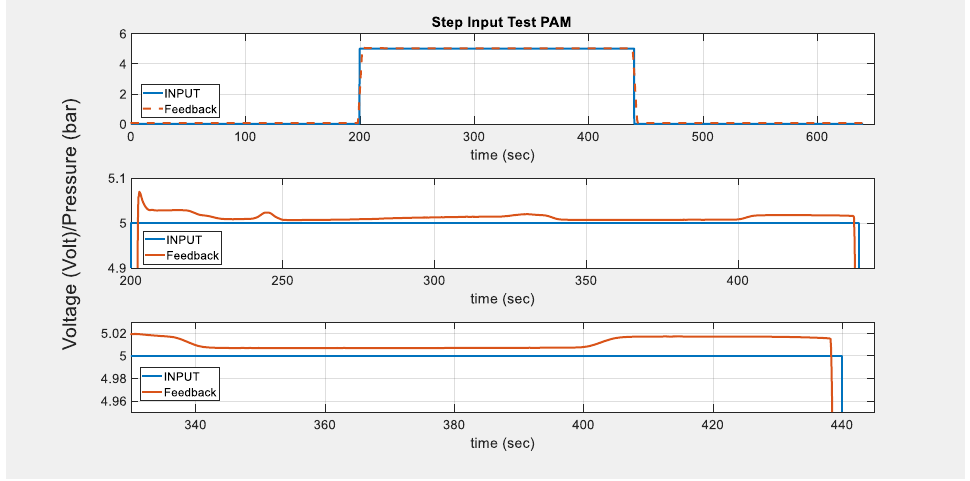
Figure 8. Single-step input voltage applied to the test muscle subplot.